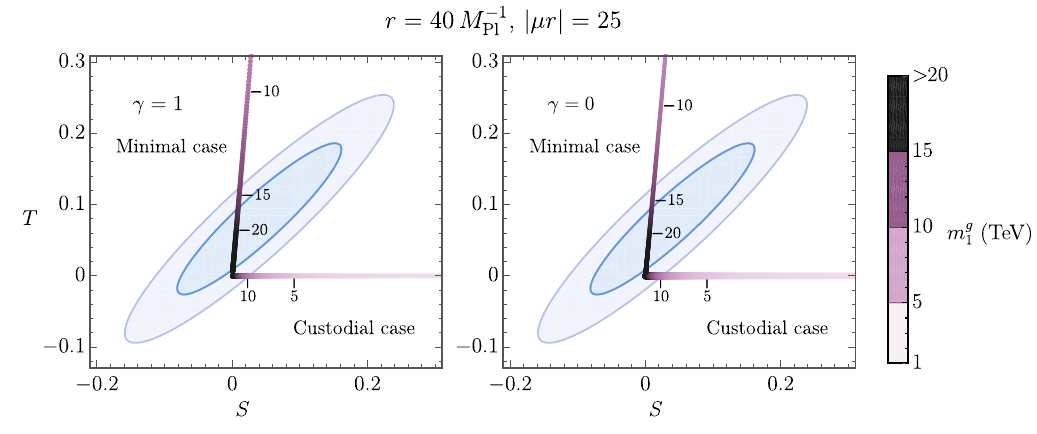
Figure 7 . Values of the S and T parameters for the scan performed on the mass of the first KK for γ = 1 (strong backreaction) and 0 (no backreaction limit). The color bar shows the gluon m g 1 in TeV. The blue contours show the 68% and 95% CL re- values of the mass of the first KK gluon m g 1 gions in the S T plane allowed by EWPT [42]. For the left panel we have fixed the parameters to be − µr = 25 and γ = 1. The right panel shows the no backreaction limit, i.e. γ = 0, for the same value | | of µr . The horizontal T = 0 points refer to the custodial case, whereas vertically inclined points are | | for the minimal case. Some of the scan points are marked with their corresponding m g